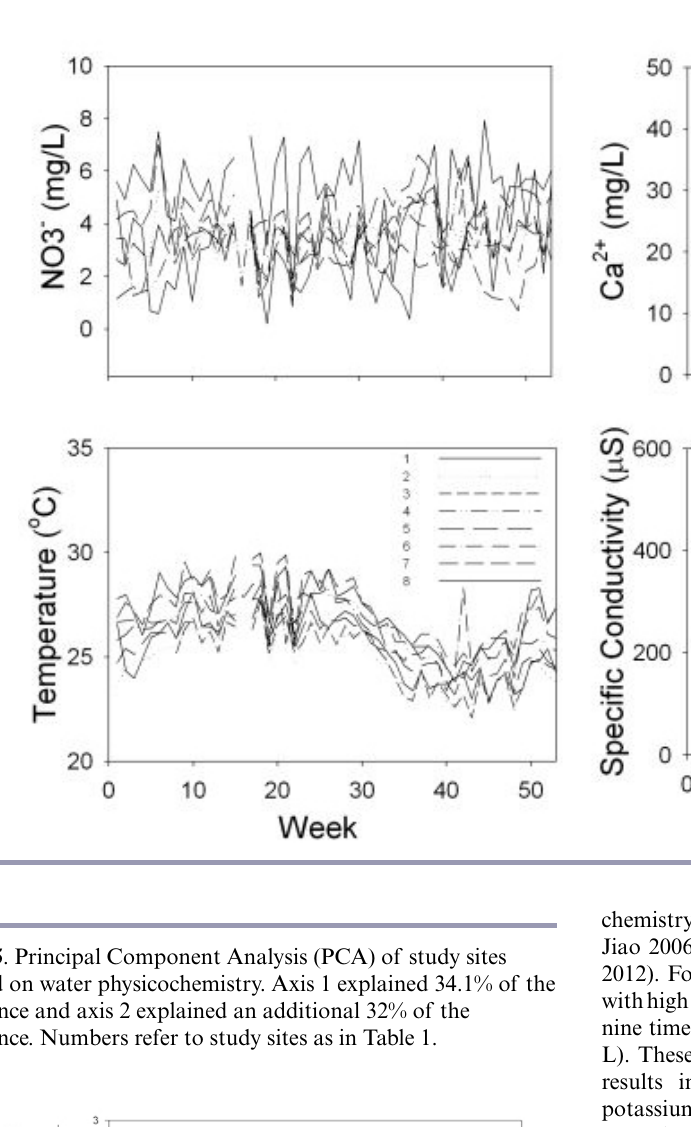
Fig. 4 . Temporal weekly patterns for some representative stream physicochemical variables in the Río Piedras Watershed.